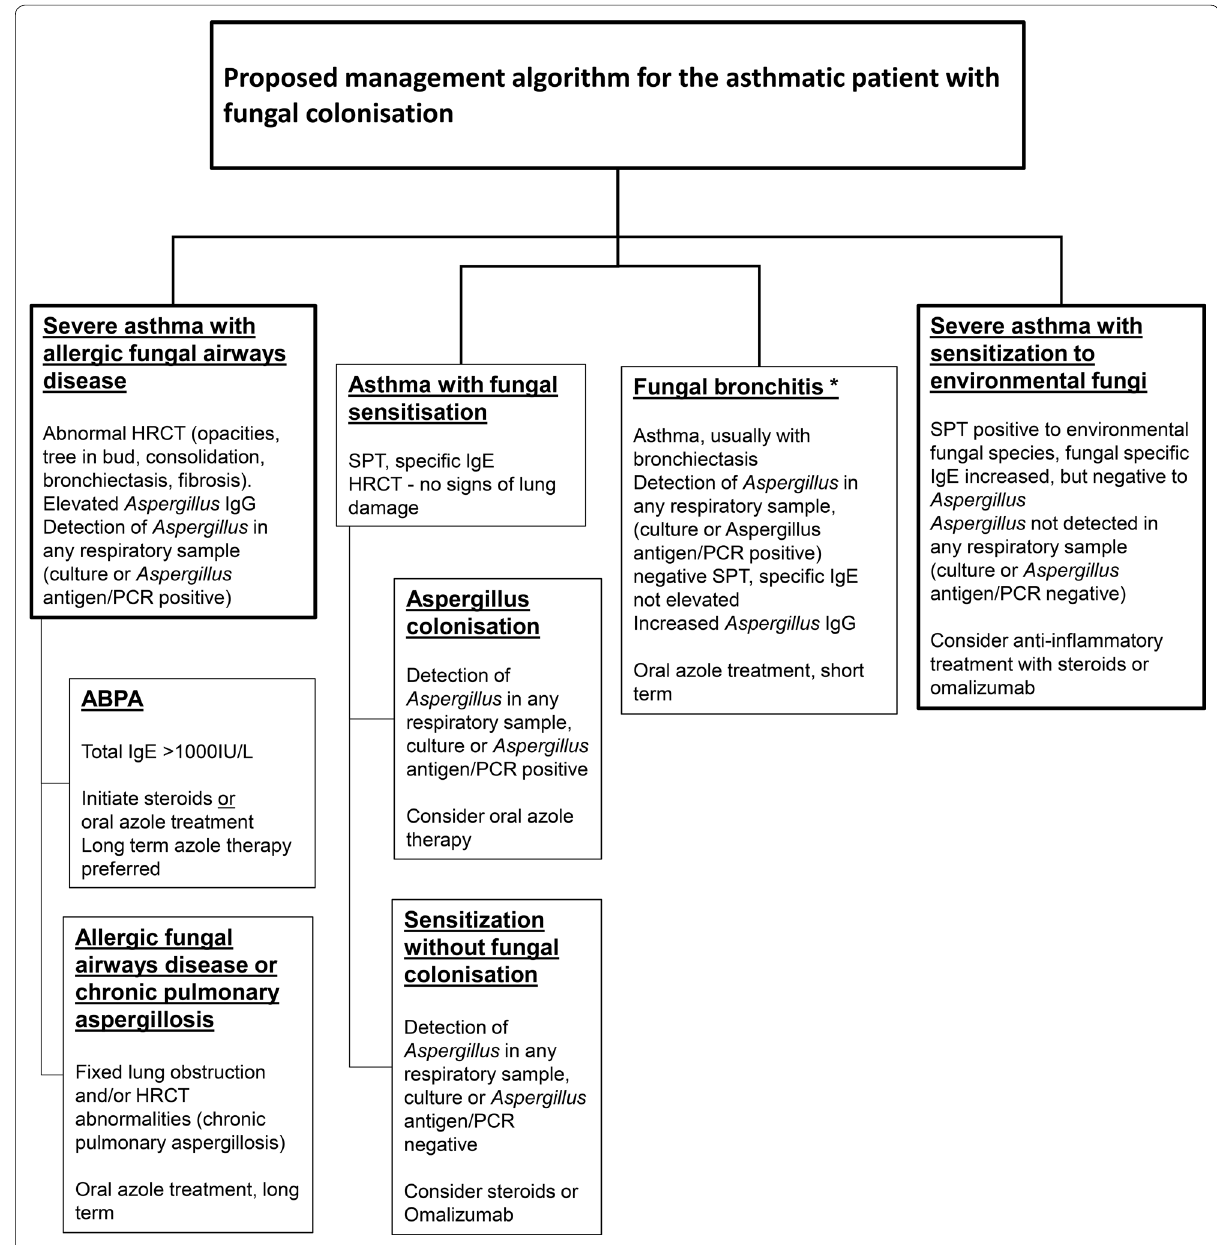
Fig. 3 Proposed management algorithm for the asthmatic patient with fungal colonisation. * The diagnosis of fungal bronchitis must be actively sought with at least two positive specimens for fungal culture or PCR (https ://www.asper gillu s.org.uk/conte nt/asper gillu s-bronc hitis )